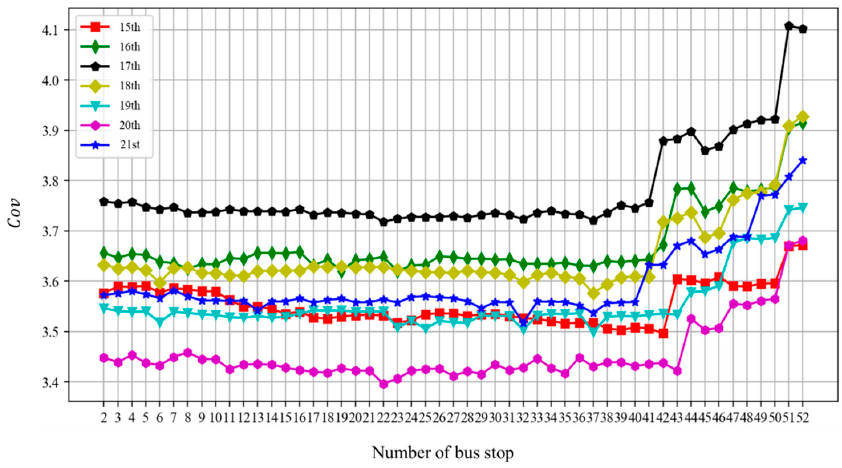
Figure 8. Variation of 𝐶𝑜𝑣 on a work day and non-work day.